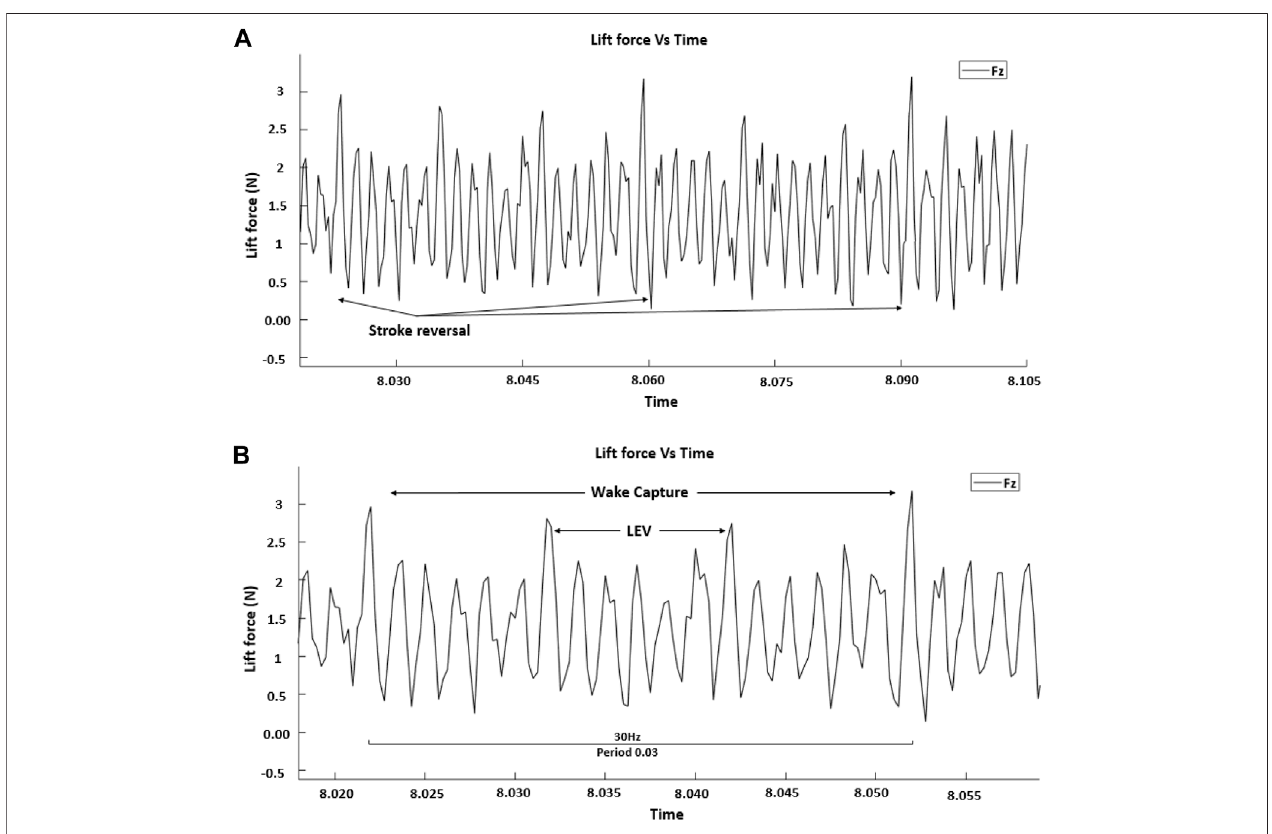
FIGURE 6 | Cyclic averaged data showing (A) multi periods and (B) a single period.